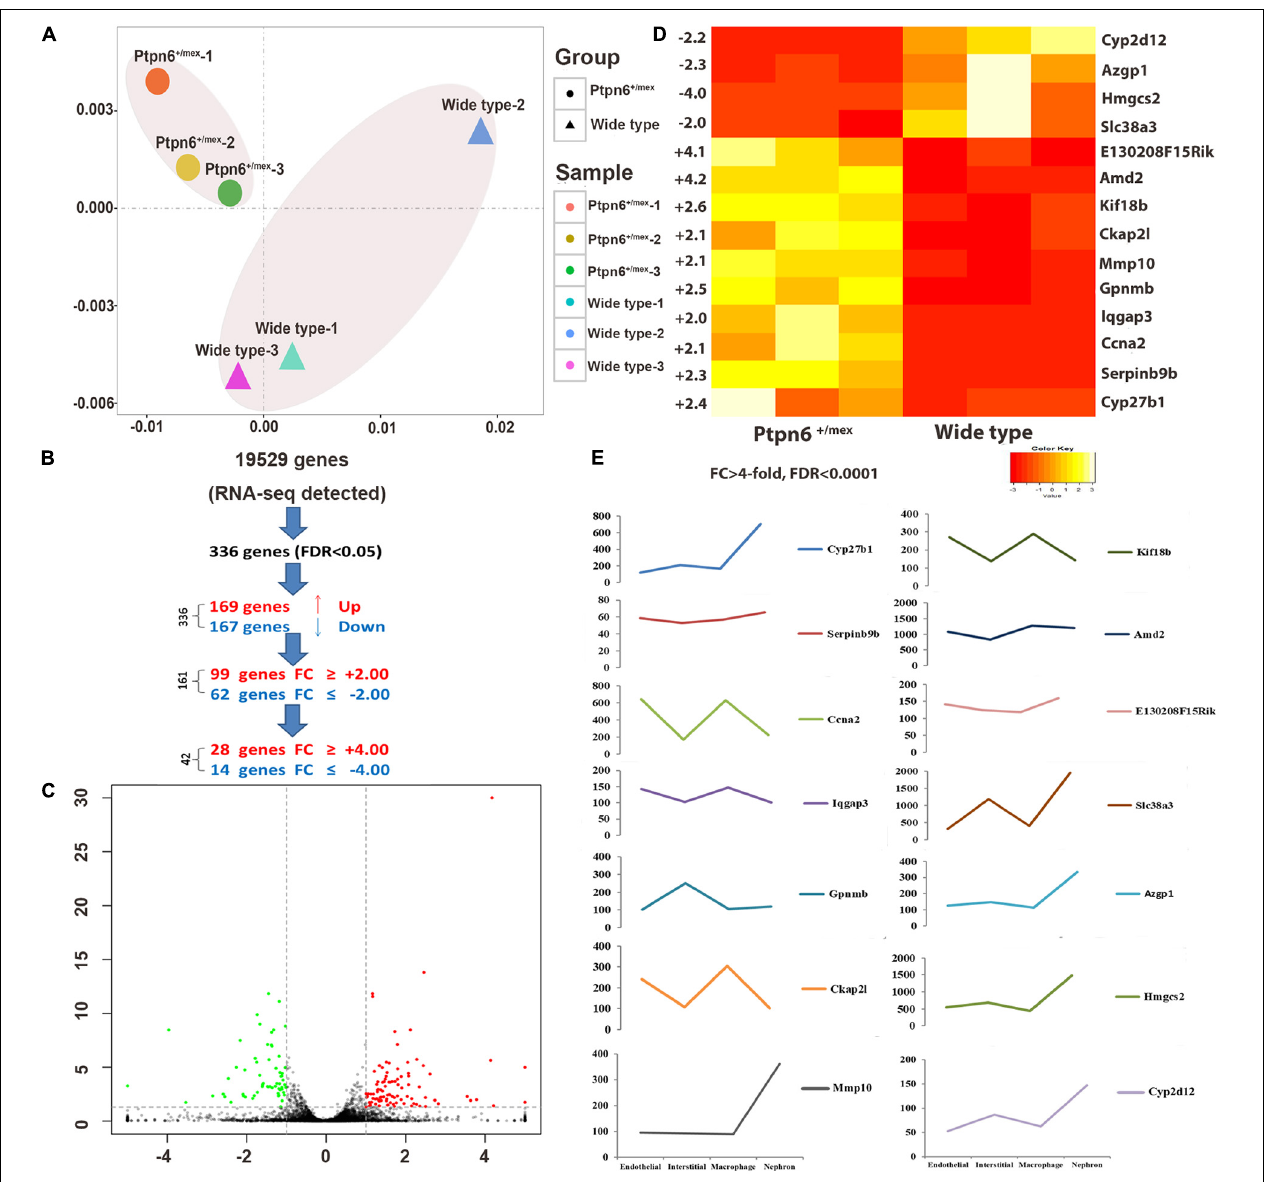
FIGURE 2 | Differentially expressed genes (DEGs) in the kidneys of wild-type and Ptpn6 + / mev mice after renal IRI. (A) The PCA plot of the Ptpn6 + / mev samples (circles) shows distinct differences between samples from wild-type mice (triangles): each graph represents all DEGs of one animal, and the most similar Ptpn6 + / mev samples (circles) are located the closest. (B) A total of 336 genes out of 19,529 genes detected by RNA-seq were differentially expressed (FDR < 0.05). (C) A total of 161 genes showed at least twofold up-or down-regulation at FDR < 0.05. (D) Fourteen highly DEGs (FDR < 0.0001) in homozygous Ptpn6 + / mev kidneys compared to wild-type littermates. (E) Expression changes of 14 DEGs in different types of renal